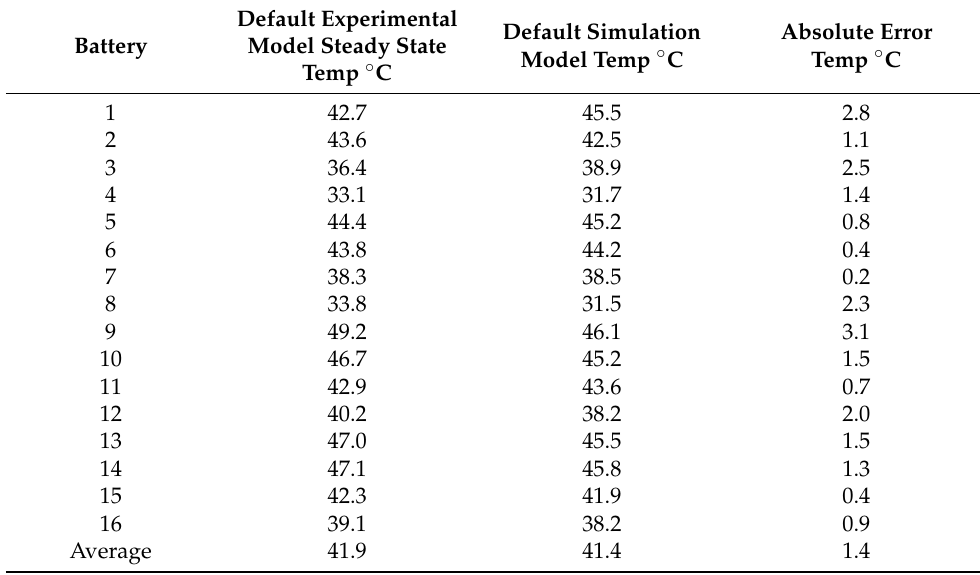
Table 5. Vented design experimental and simulation temperature comparison.